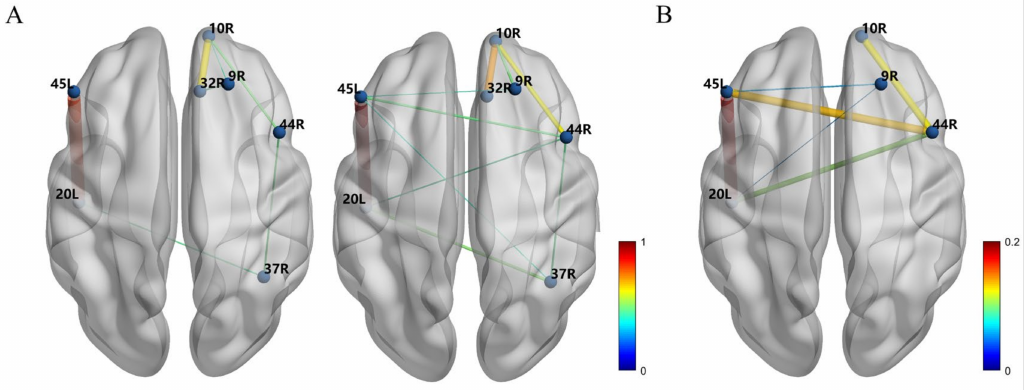
Figure 5. The topography of the PMI matrix results. ( A ) show the PMI topography in the innocent group and lying group. ( B ) represents the difference topography between the innocent group and the lying group